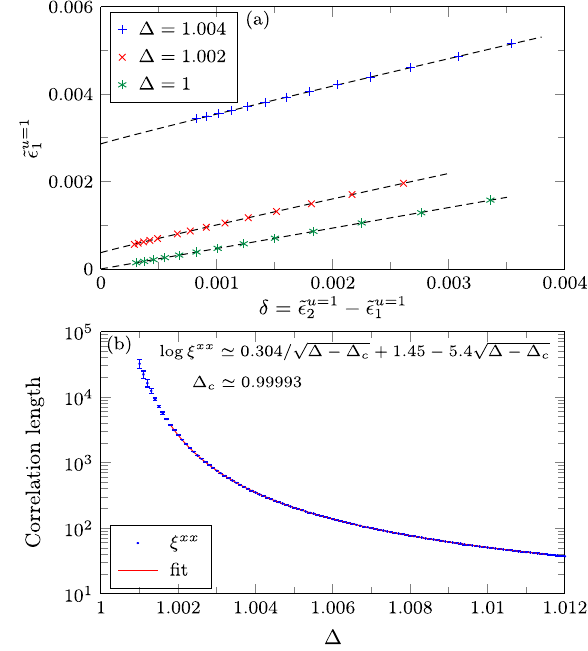
41.3FIG. 5. XXZ spin- 3 = 2 model. (a) Extrapolation of the corre- lation length for selected values of Δ . Refinement parameter δ